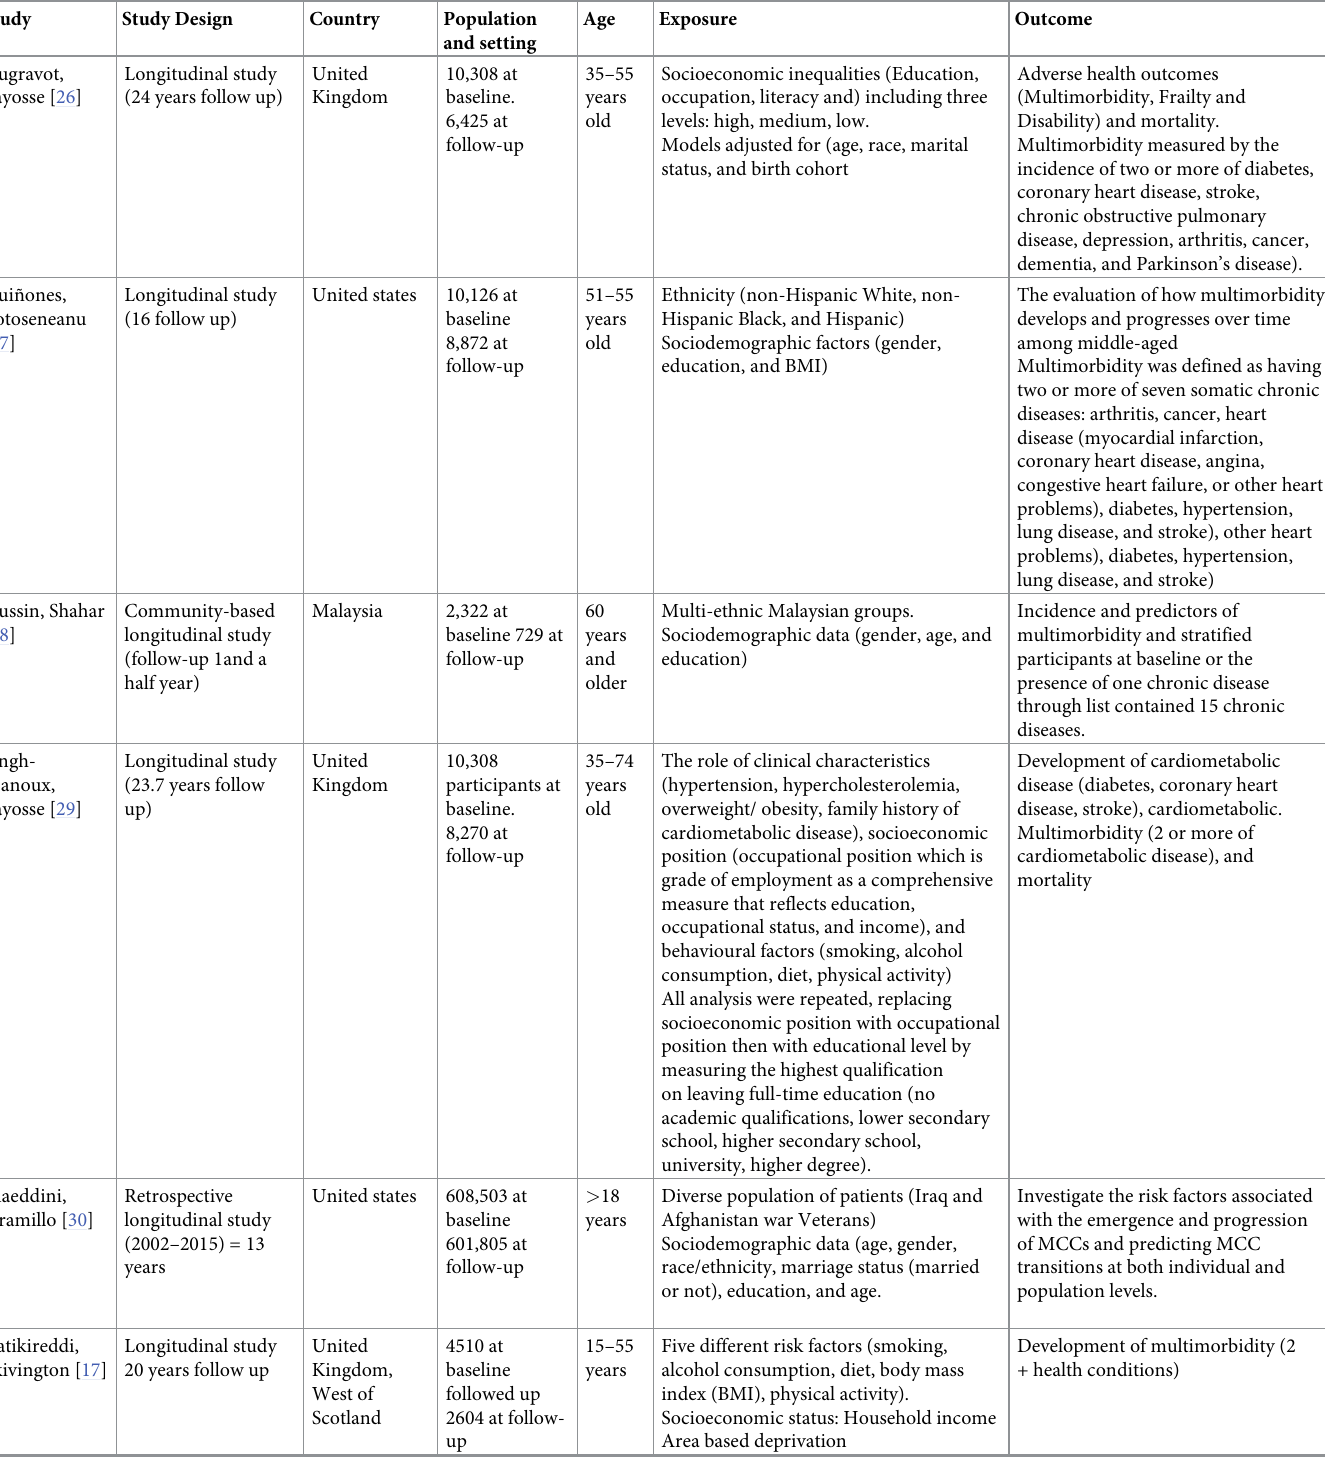
Table 2. Characteristic of longitudinal studies on socioeconomic inequality in progress of multiple chronic